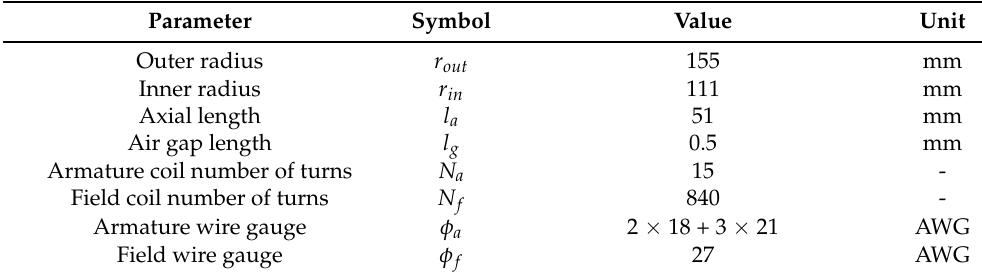
Table 2. Dimensional limitations for the